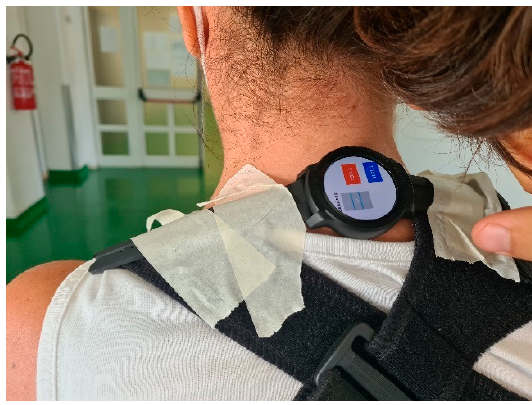
Figure 2. One option for smartwatch positioning.